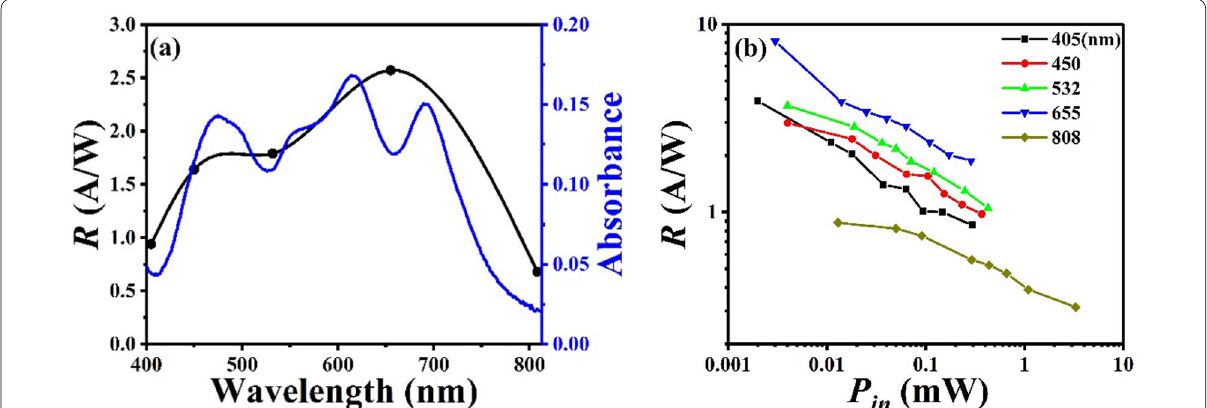
Fig. 4 a The dependence of photoresponsivity R on the wavelength. b The logarithmic dependences of R on the incident optical power P in . All results were obtained at a reverse bias voltage of 10 V and an incident optical power of ~ 0.1 mW −